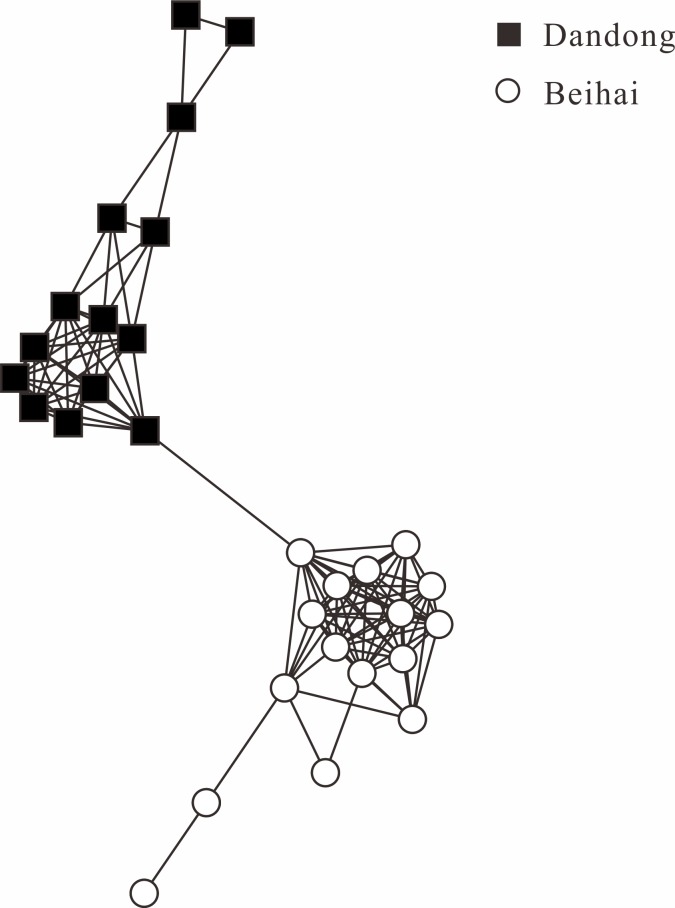
The genetic relationships among individuals of Beihai and Dandong illustrated by the NetView P analysis.